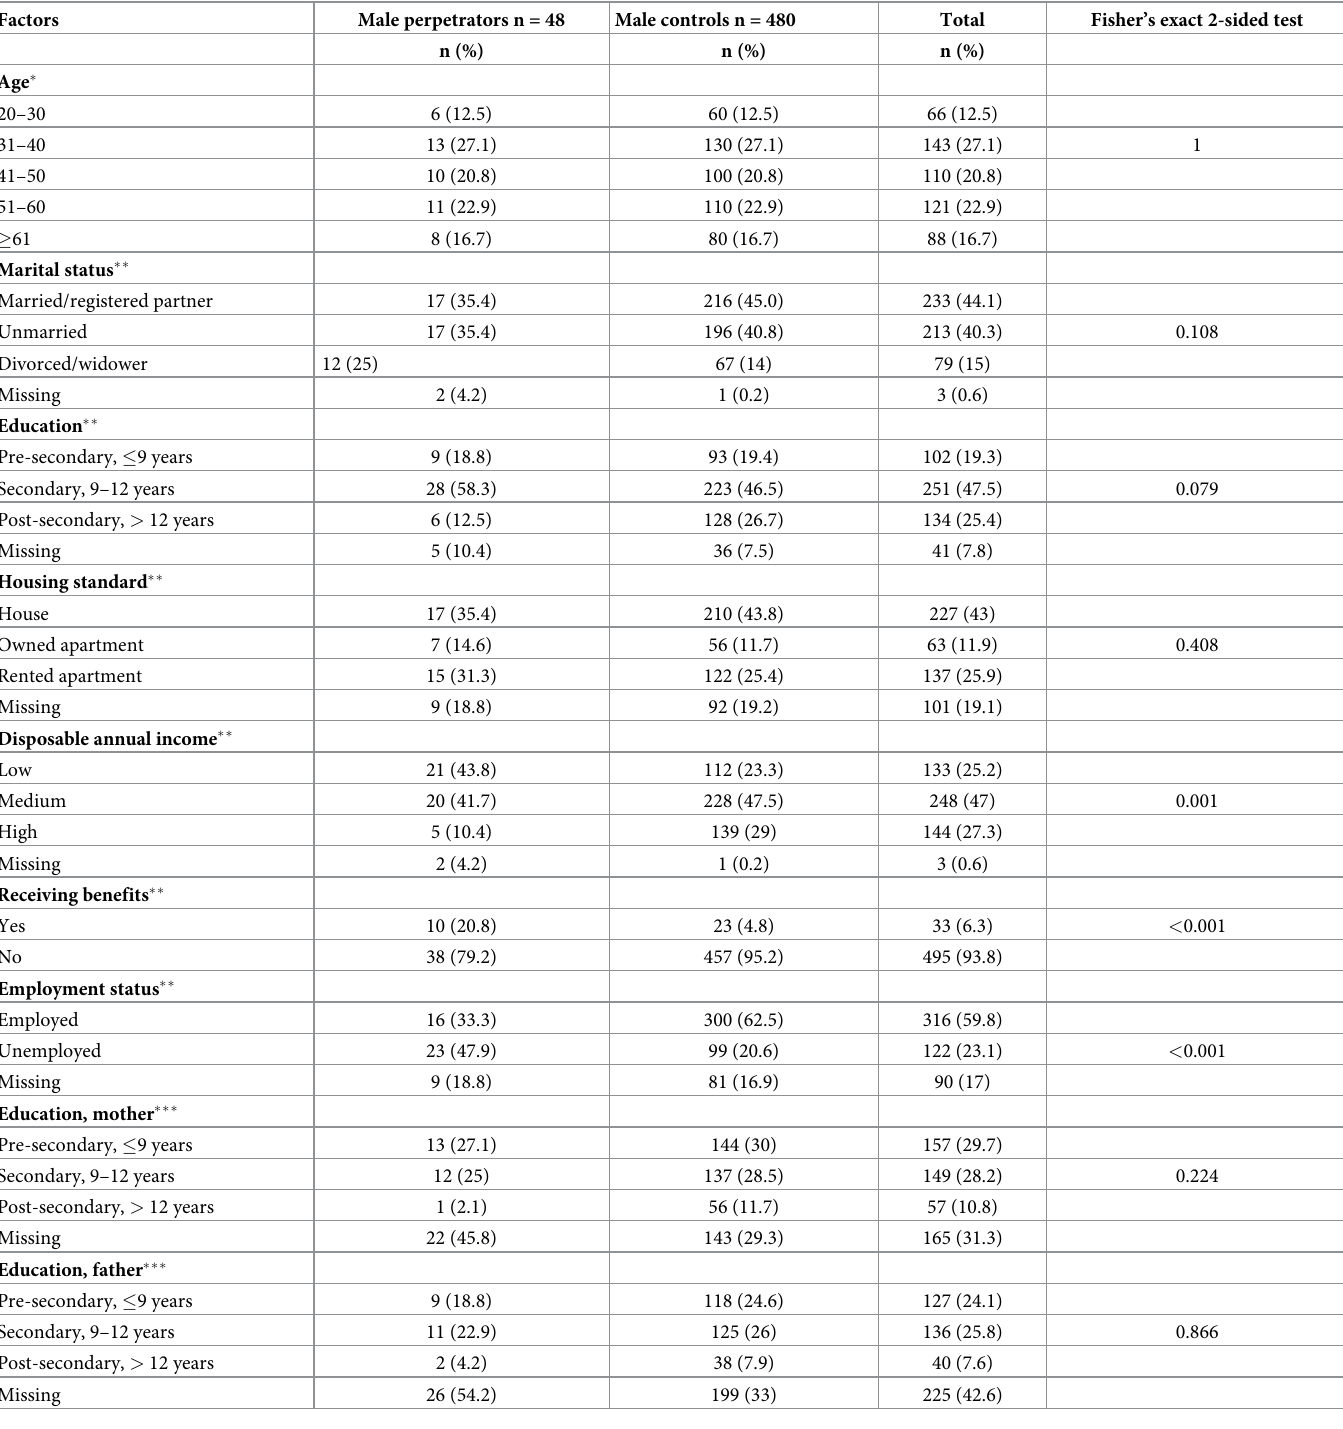
Table 2. Socio-demographic characteristics of male perpetrators, male controls and the total population. NN = 528, 48 perpetrators and 480 controls.